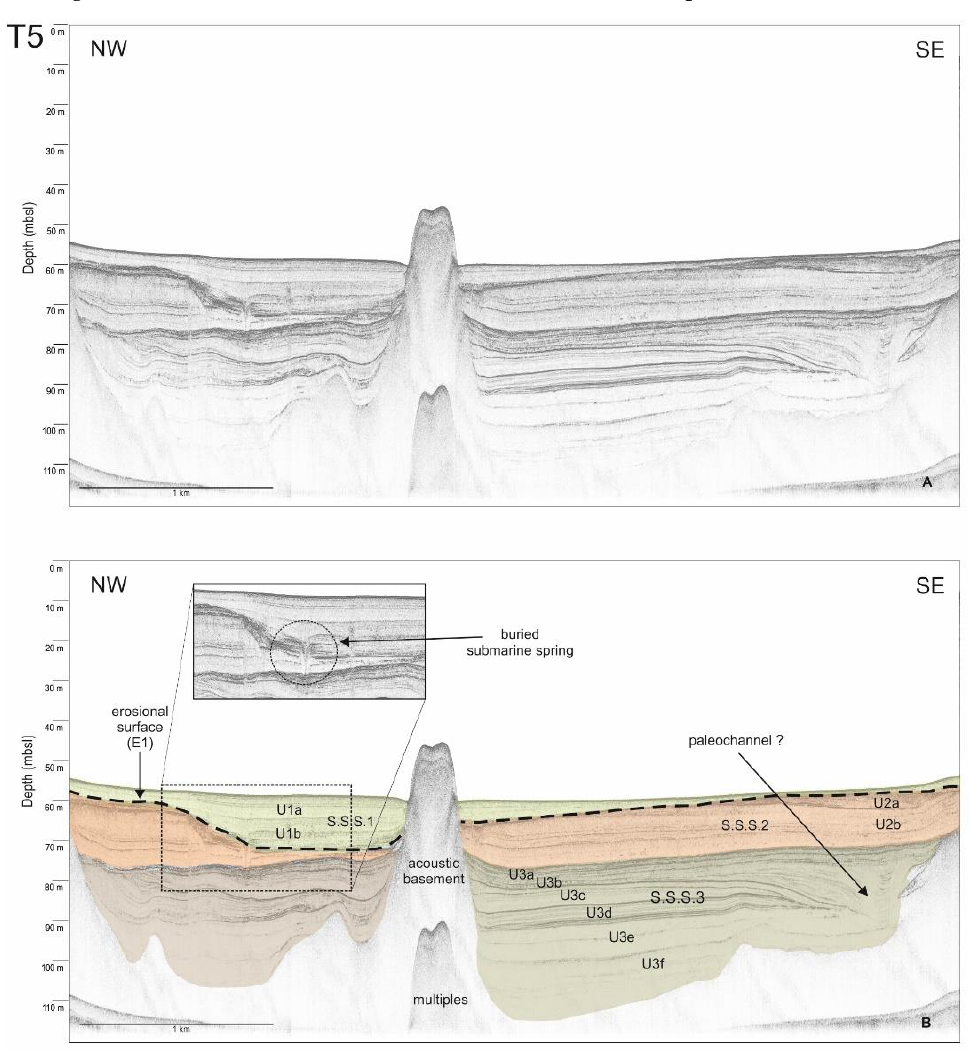
Figure 4. ( A ) High-resolution seismic profile of seismic line T5 and ( B ) its stratigraphic interpretation. The location of the line is shown in Figure 1.